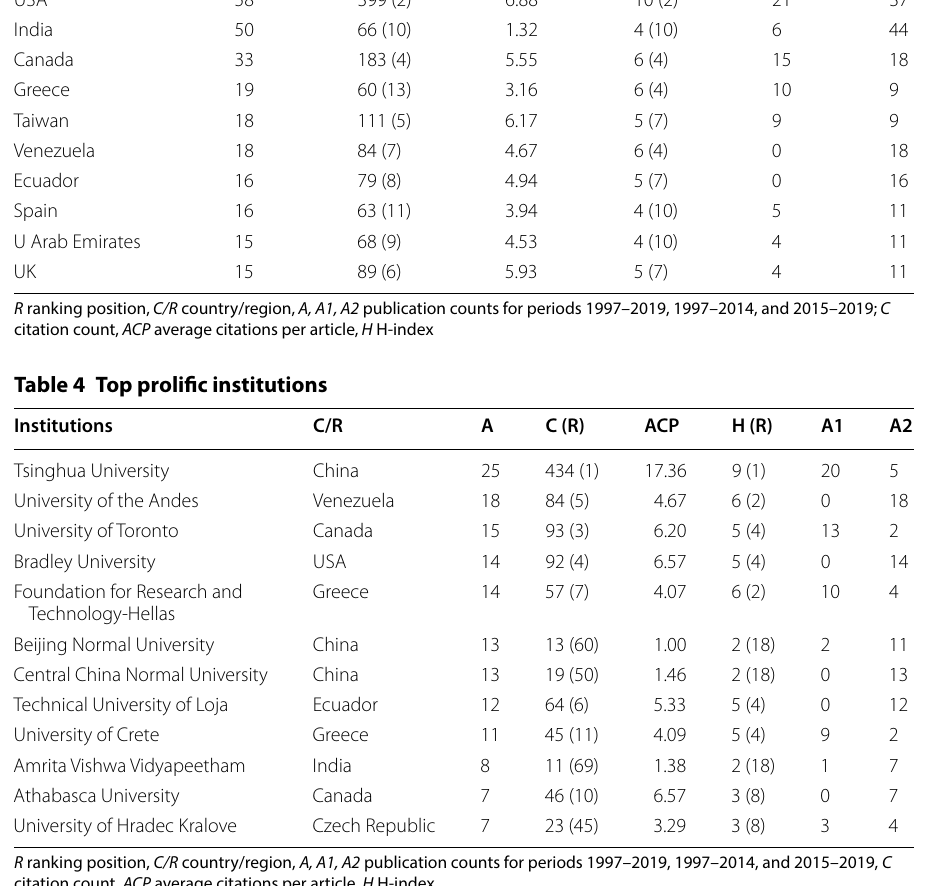
R ranking position, C/R country/region, A, A1, A2 publication counts for periods 1997–2019, 1997–2014, and 2015–2019, C citation count, ACP average citations per article, H H‑index